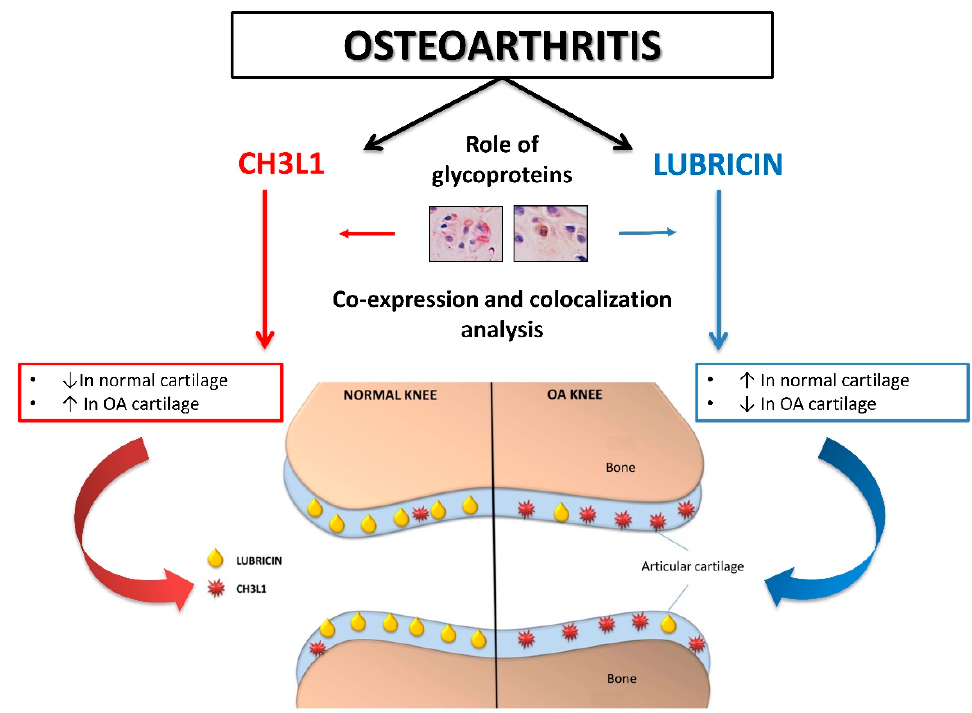
Figure 7. Graphical representation of the involvement of two glycoproteins (CHI3L1 and lubricin) in normal and osteoarthritic articular cartilage. Red arrows (CHI3L1 pathway); Blue arrows (lubricin pathway).